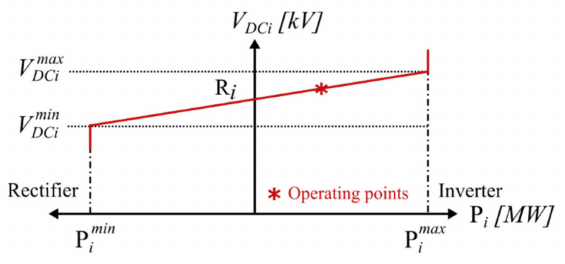
Figure 5. Droop control